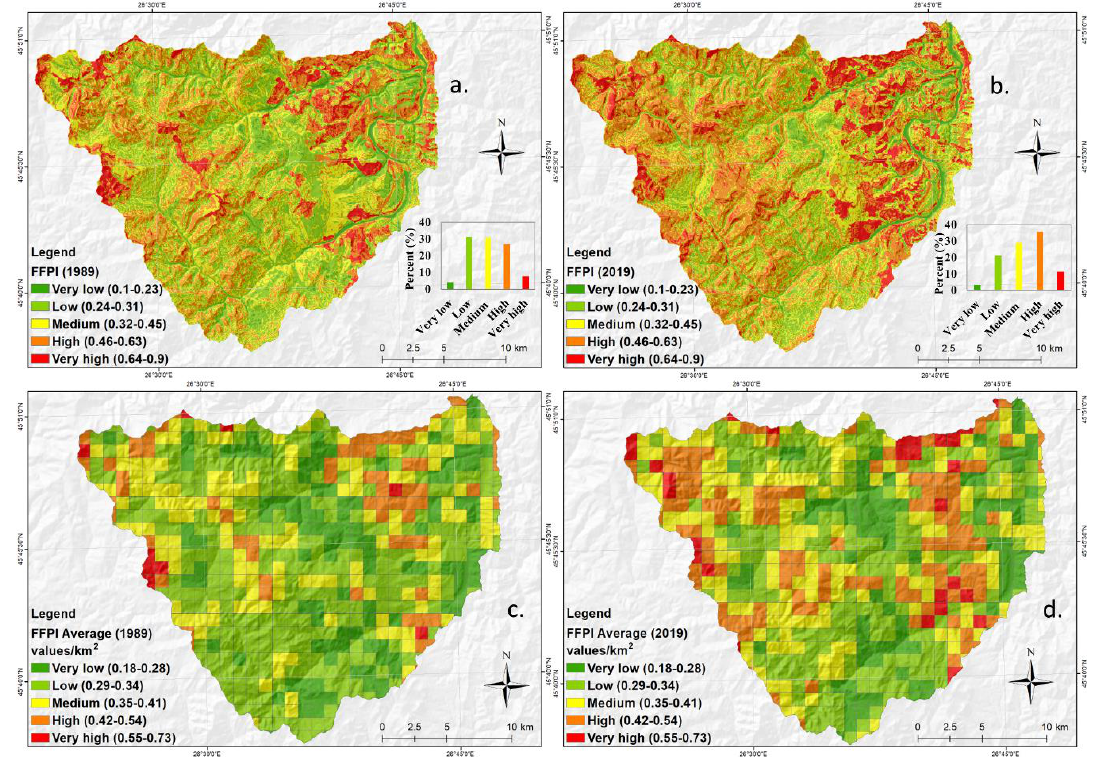
Figure 8. FFPI values: ( a ) 1989, ( b ) 2019, ( c ) 1989 (values/km 2 ), and ( d ) 2019 (values/km 2 ).